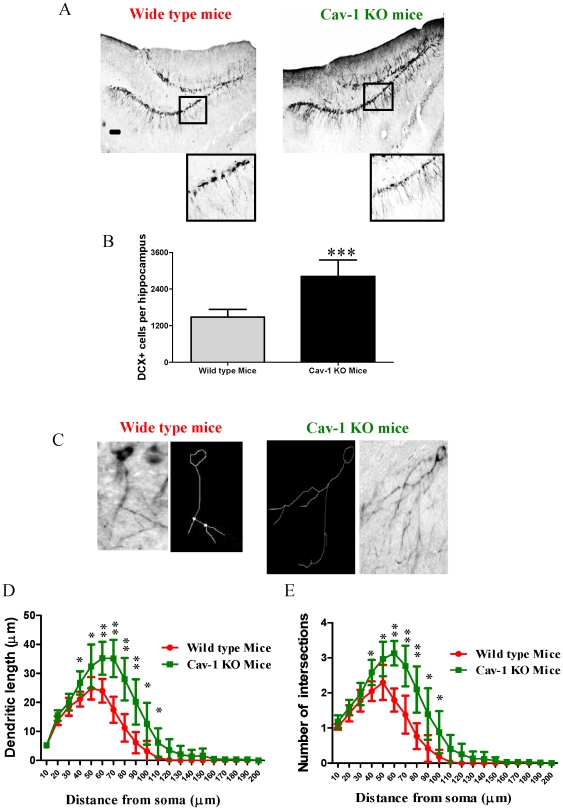
Neuronal regeneration in the granule cell layer of the hippocampal dentate gyrus of wild type and Cav-1 KO mice.
A. Representative micrographs of the immature neuronal marker, doublecortin (DCX), in the granule cell layer of the hippocampal dentate gyrus of wild type mice and Cav-1 KO mice. Scale bar = 100 µm B. Histograms showing the quantification of DCX positive cells in wild type mice and Cav-1 KO mice (Mean ± S.D., n = 6). Wild type mice versus Cav-1 KO mice, *** p<0.001. C. Representative image and traces from Sholl analysis of DCX positive cells with tertiary branches in wild type mice and Cav-1 KO mice. D. Cav-1 KO mice had longer dendrites of DCX positive cells than wild type mice (Mean ± S.D., n = 6). The number of intersection/dendritic length represents the complexity of the dendrites. Wild type mice versus Cav-1 KO mice, *p<0.05, p<0.01; E. Cav-1 KO mice had higher numbers of intersections of DCX positive cells than wild type mice (Mean ± S.D., n = 6). Wild type mice versus Cav-1 KO mice, * p<0.05, p<0.01.